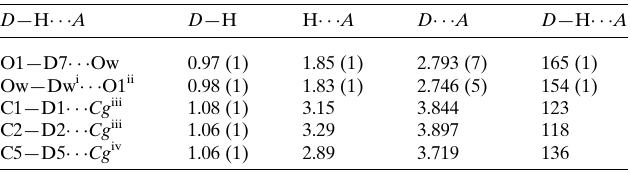
Table 1 Hydrogen-bond geometry (A˚ , (cid:4) ). Cg is the centroid of the C1–C6 ring located at (0.310, 0.634, 0.451). D —H (cid:2)(cid:2)(cid:2) A